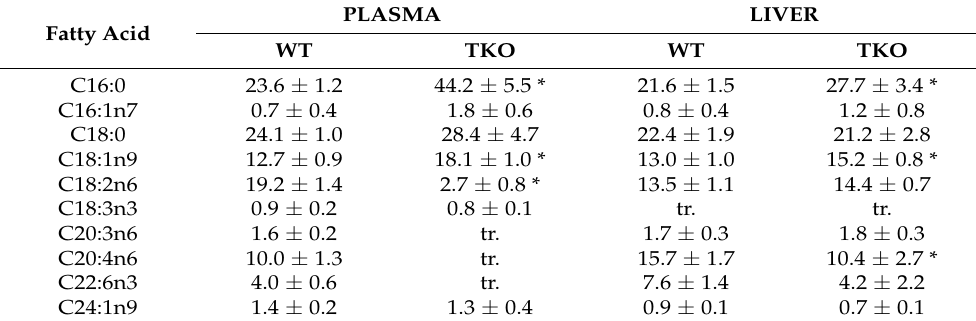
Table 1. Fatty acid composition of the total polar lipids (% of TPL fatty acids) in plasma and liver from triple-synuclein null mutant (TKO) and wild-type (WT)